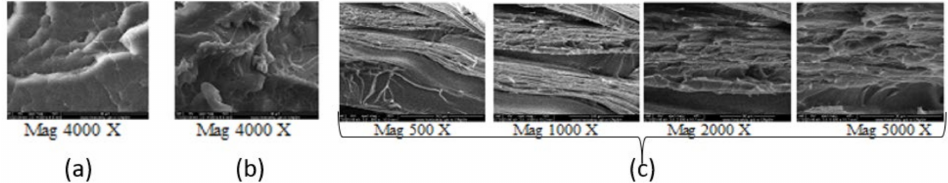
Figure 10. SEM micrographs base-PLLA (P b ) ( a ), stereo-complexer PDLA (P m1 ) ( b ) and resulting stereo-complexed compound sc-1 ( c ).